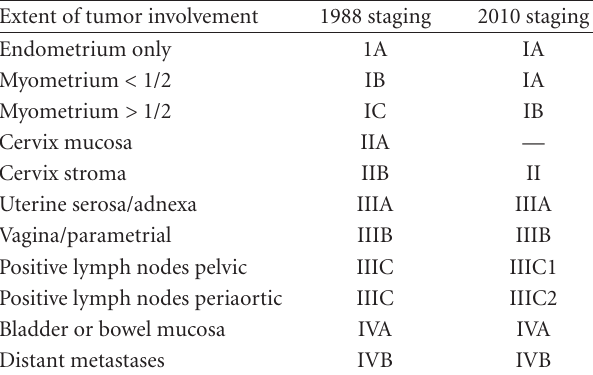
Table 1: Comparison of 1988 and 2010 surgical staging system for endometrial cancer.